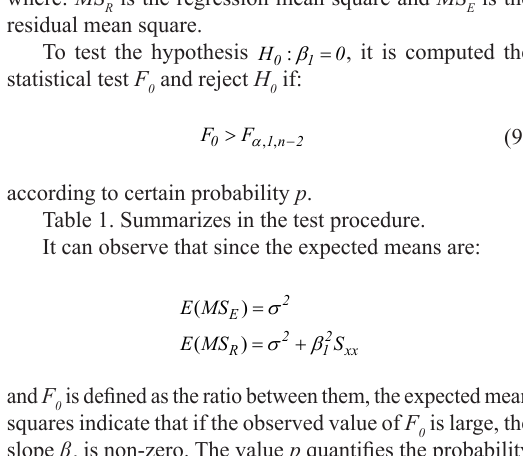
and F is defined as the ratio between them, the expected mean 0 squares indicate that if the observed value of F slope β is non-zero. The value p quantifies the probability 1 reached.